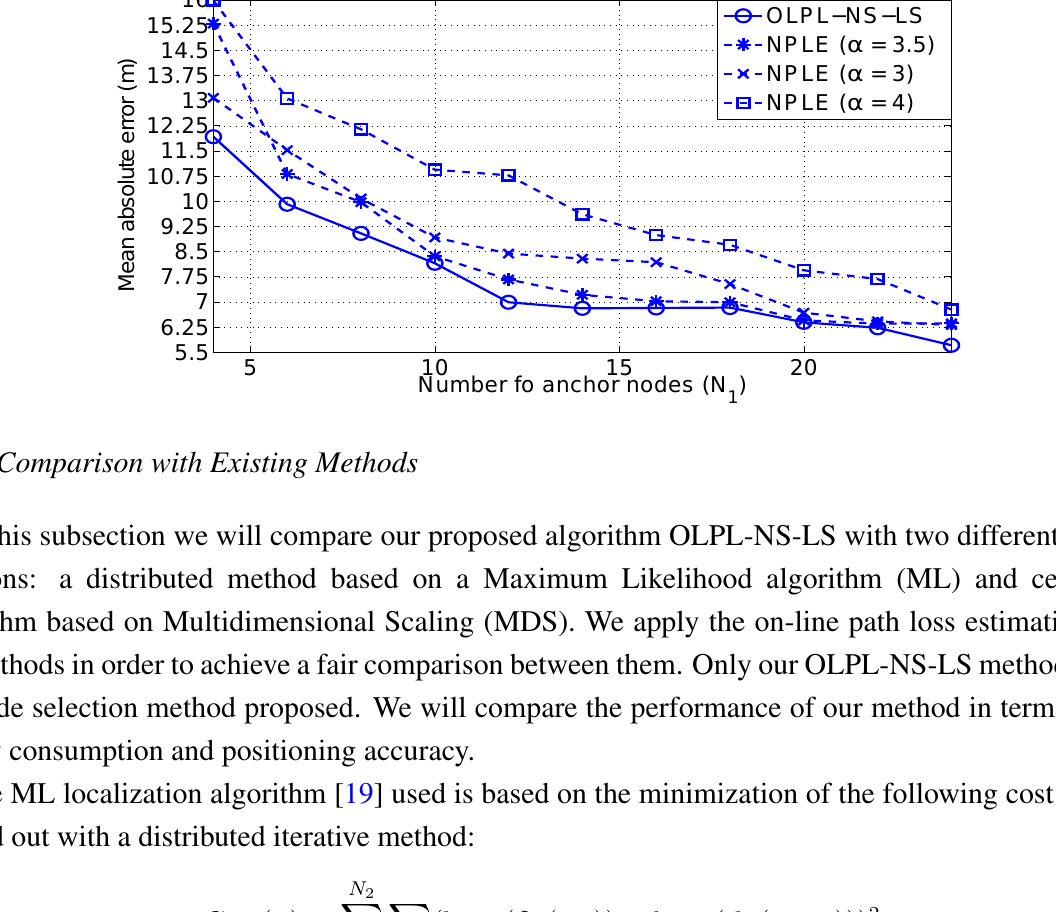
) (solid line: lower dis- 1